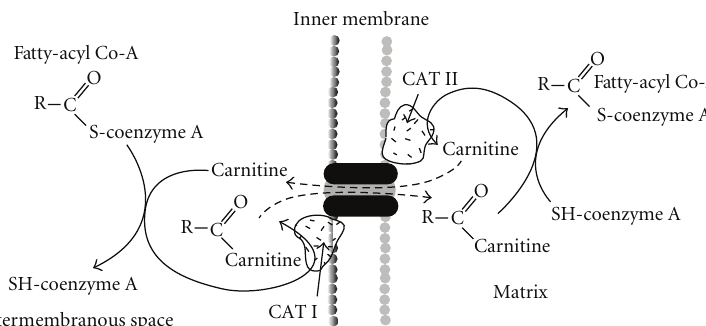
Figure 13: Transport of long chain ( > 15 carbons) fatty acyl CoA molecules into the mitochondria via the carnitine shuttle.